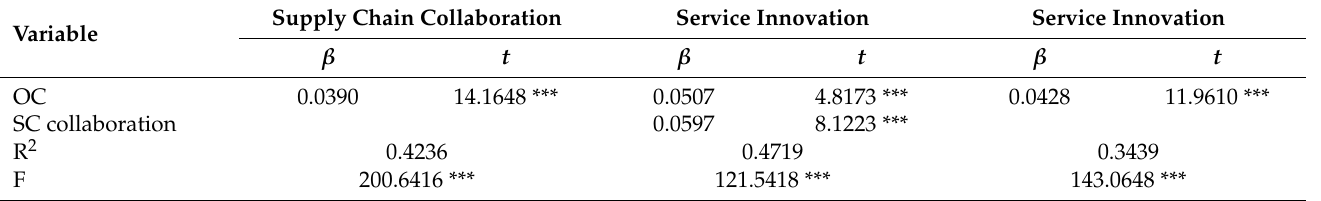
Table 7. Intermediary model test of SSC collaboration.